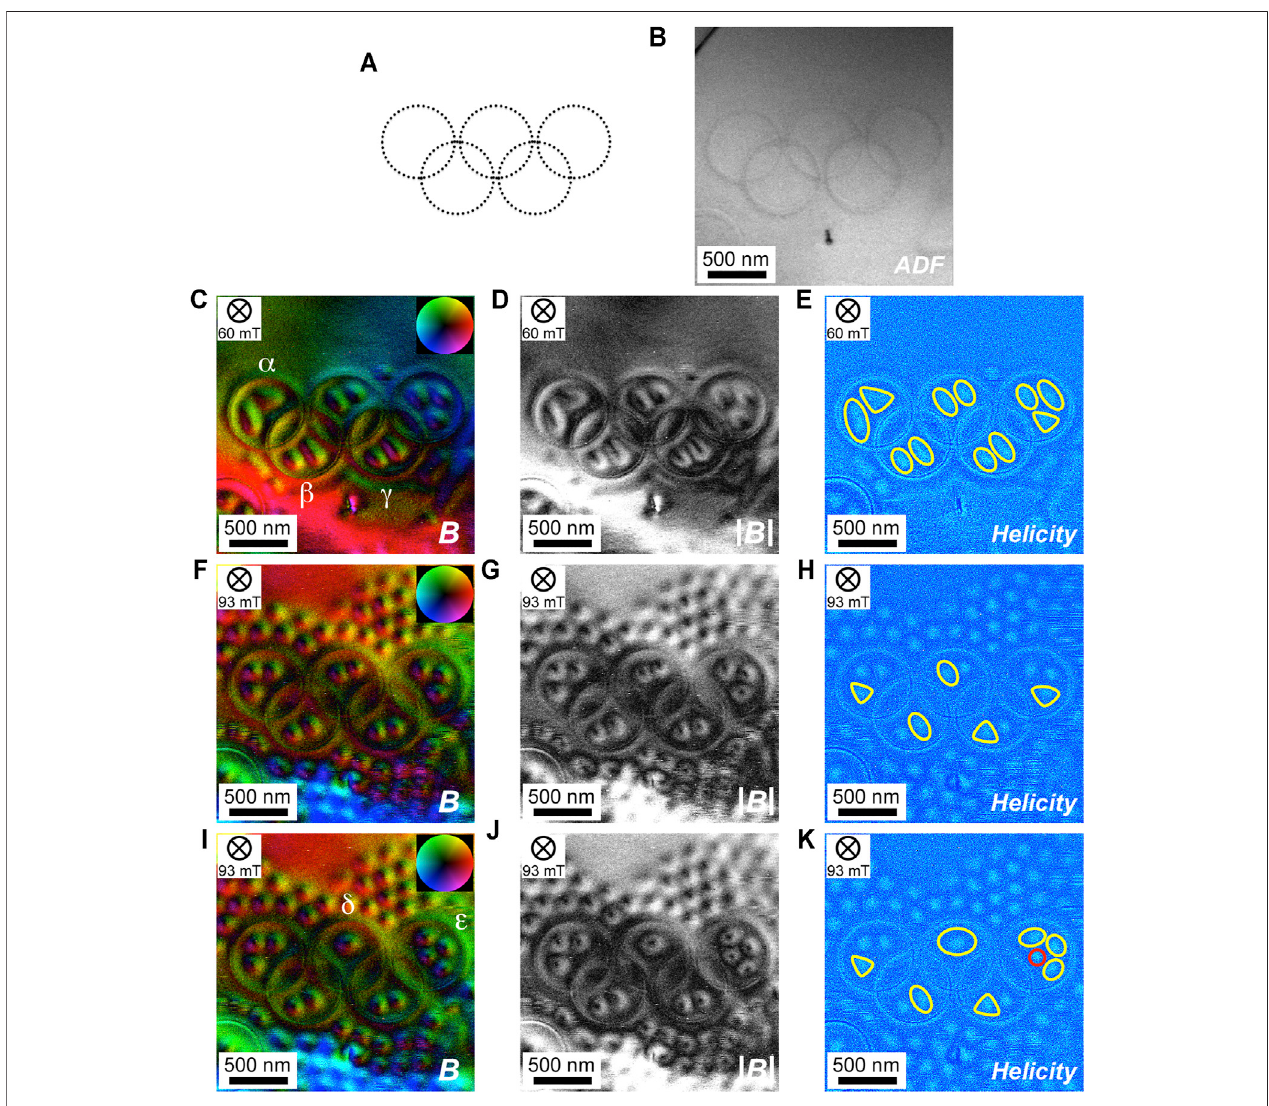
FIGURE4| Individual skyrmions con fi ned toasurface-pitcorral withacomplexgeometry (Olympic symbol)undermoderate-bias fi elds. (A) Aschematicofthe fi ve interlaced rings of equal dimensions (630 nm in diameter). (B) Annular dark- fi eld image of the fabricated pattern on the thin-plate specimen. (C – E) Individual skyrmions under the perpendicular magnetic fi eld of 60 mT. (F – H) Individual skyrmions under the perpendicular magnetic fi eld of 93 mT. (I – K) Individual skyrmions under the perpendicular magnetic fi eld of 93 mT with a slight change of the specimen orientation from the one shown in (F – H) . (C , F , I) In-plane magnetic induction as a color map, (D , G , J) as intensity, and (E , H , K) magnetic helicity image. Several deformed skyrmions, not only in shape but also in size, are indicated by yellow shapes in the magnetic helicity images in (E , H , K) . A compressed circular skyrmion is indicated by a red circle in (K) . Pixel dwell time is 1 ms.